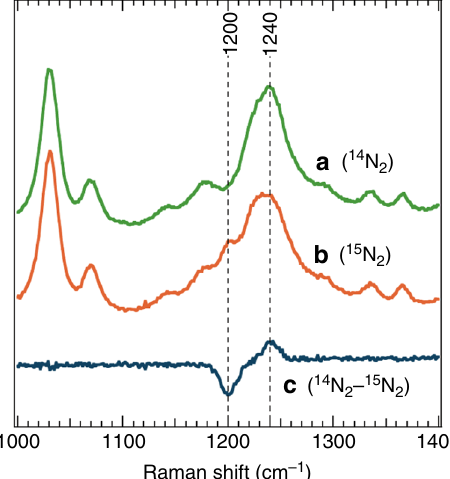
Fig. 4 Spectroscopic characterization of the Ti-N = N-Ti moiety. Resonance- Raman spectra for 3 ( a , green line) and 15 N-labeled 3 ( b , orange line), as well as their difference spectrum ( c , dark blue line) in THF at – 30